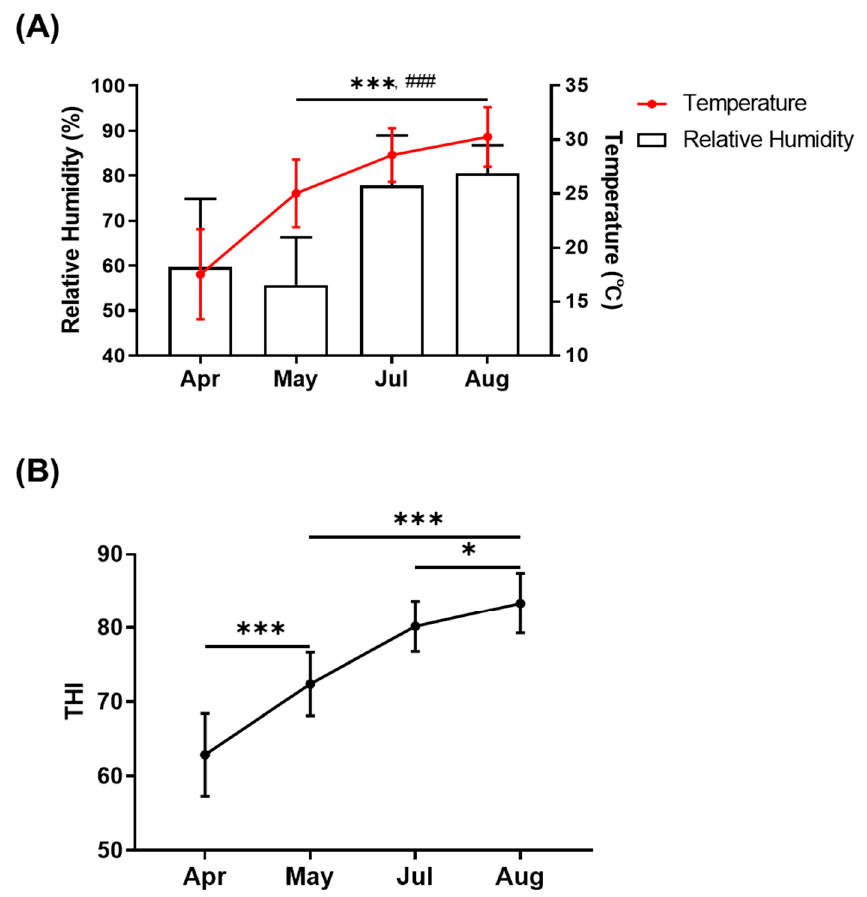
Figure 1. Changes in the temperature–humidity index (THI) in this study. Monthly average of temperature and relative humidity ( A ). Monthly average of THI derived from temperature and humidity ( B ). Data are represented as means ± standard deviation (SD). Values were statistically analyzed by one-way ANOVA with Tukey’s multiple comparison test. * p < 0.05, *** p < 0.001, and ### p < 0.001. In Panel A, the asterisk (* and ***) means a significant difference in temperature, and the number sign (###) means a significant difference in relative humidity.